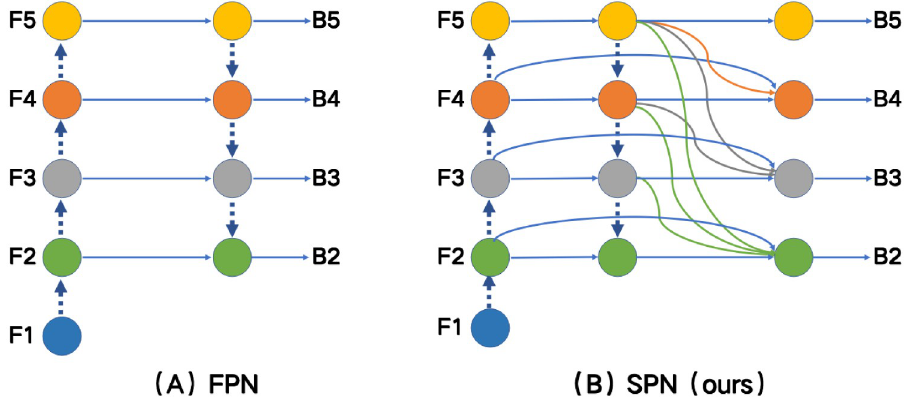
horizontal connection. (B) Enriched the semantic features through the three steps of lateral connectivity, multiple up- sampling, and feature